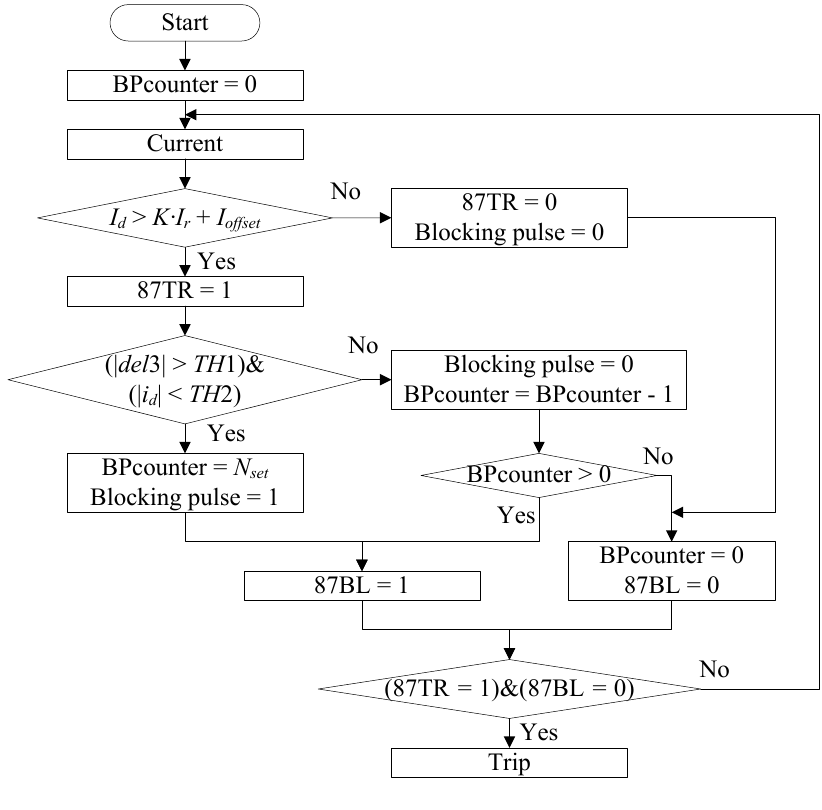
Figure 3. Flowchart of the proposed relaying